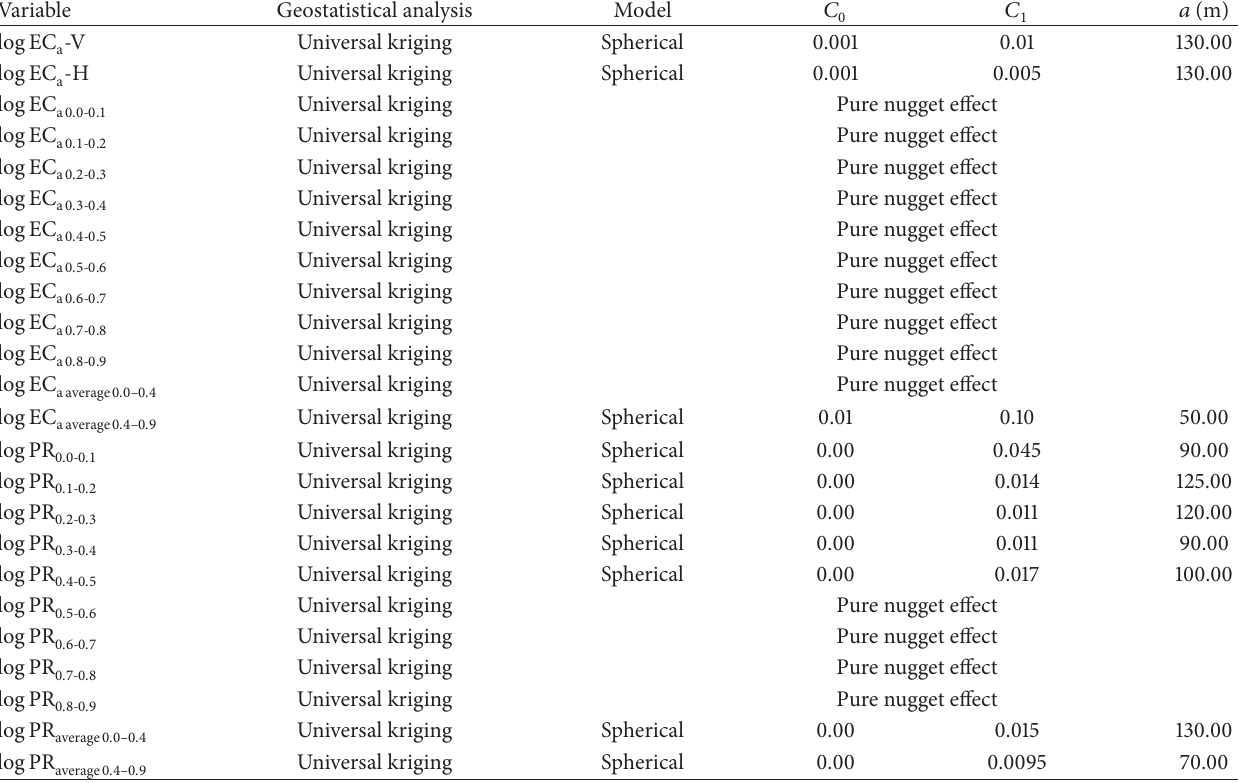
Table 3: Fitted models and variogram parameters for all the variables measured by EM38 and VERIS P3000.